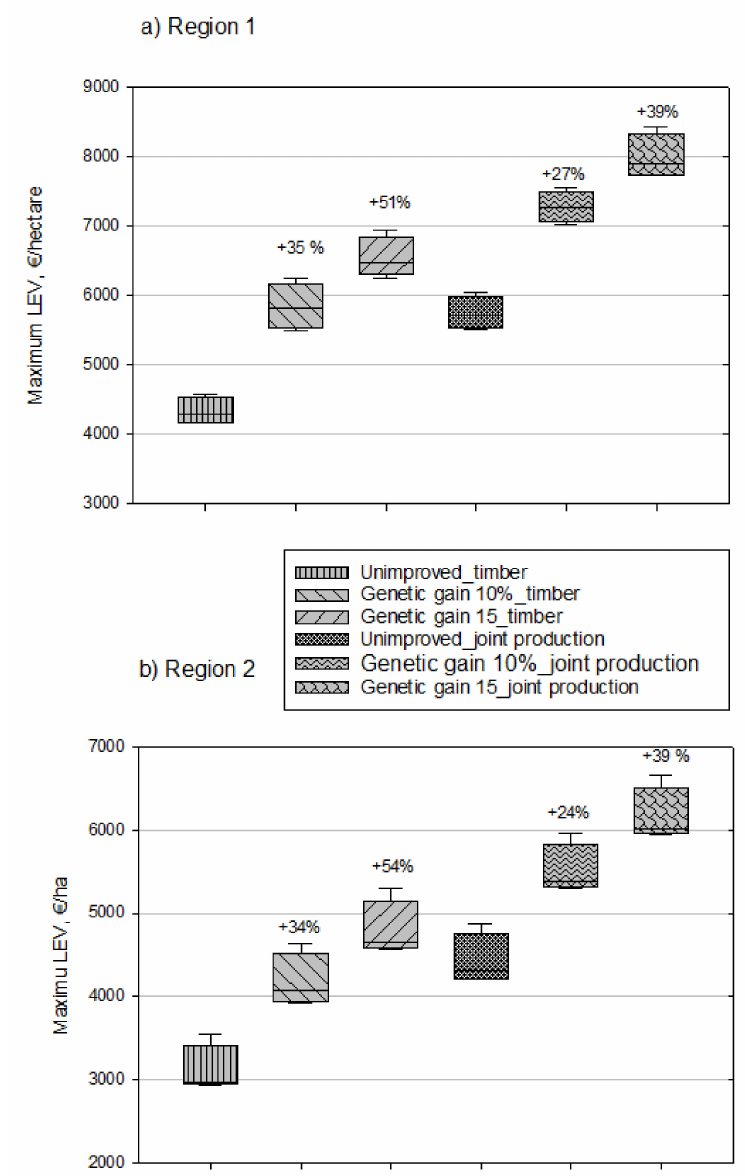
Figure 2. Maximum LEVs in Region 1 and 2, € ha − 1 . Boxplots of maximum bare land value ( € / ha), discount rate 2%. Bottom edge of each box illustrates the 25th percentile, the upper edge illustrates the 75th percentile, a line within a box marks the median, and the whiskers of the boxplots indicate the 10th and 90th percentiles. Percentages above the boxplots represent the relative increase compared to unimproved reforestation material when timber production or the joint production of timber and carbon is applied in the stand-level optimization, ( a ) Region 1, ( b ) Region 2 (for Region 1 and 2, see Figure